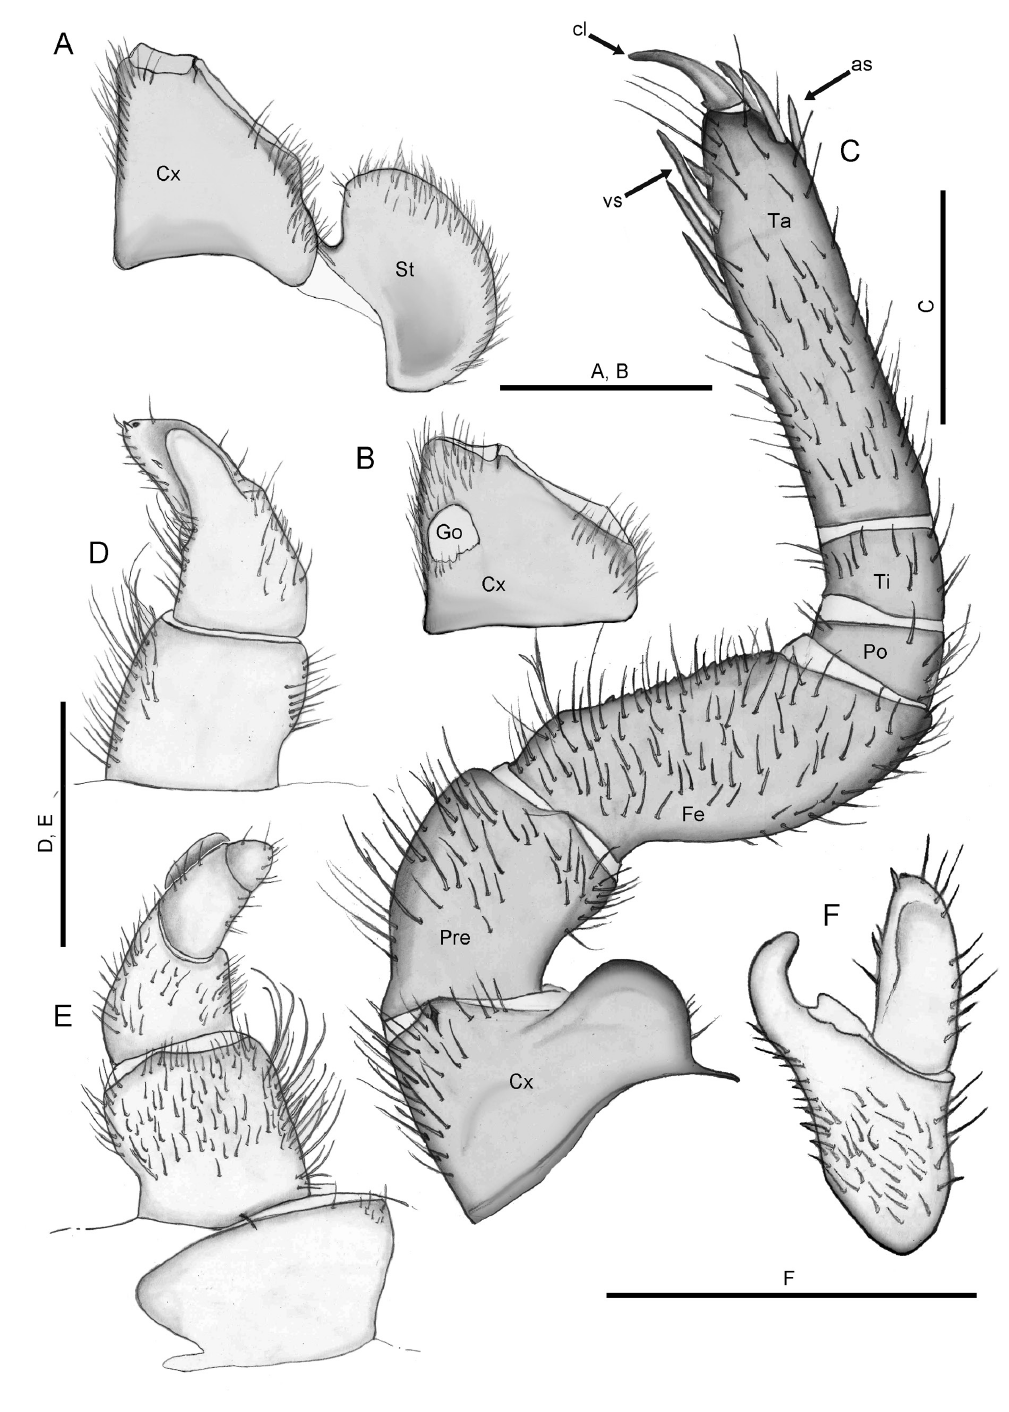
Fig. 4. Sphaerobelum aesculus Rosenmejer & Wesener sp. nov., holotype, ♂ (NHMD 621693), drawings. A . First left coxa with stigmatic plate, posterior view. B . Second left coxa with gonopore, posterior view. C . Left leg 9, posterior view. D . Left anterior telopod, posterior view. E . Left anterior telopod, anterior view. F . Left anterior telopod, lateral view on podomeres 2–4. Abbreviations: as = apical spine; cl = claw; Cx = coxa; Fe = femur; Go = gonopore; Po = postfemur; Pre = prefemur; St = stigmatic plate; Ta = tarsus; Ti = tibia; vs = ventral spines. Scale bars = 1